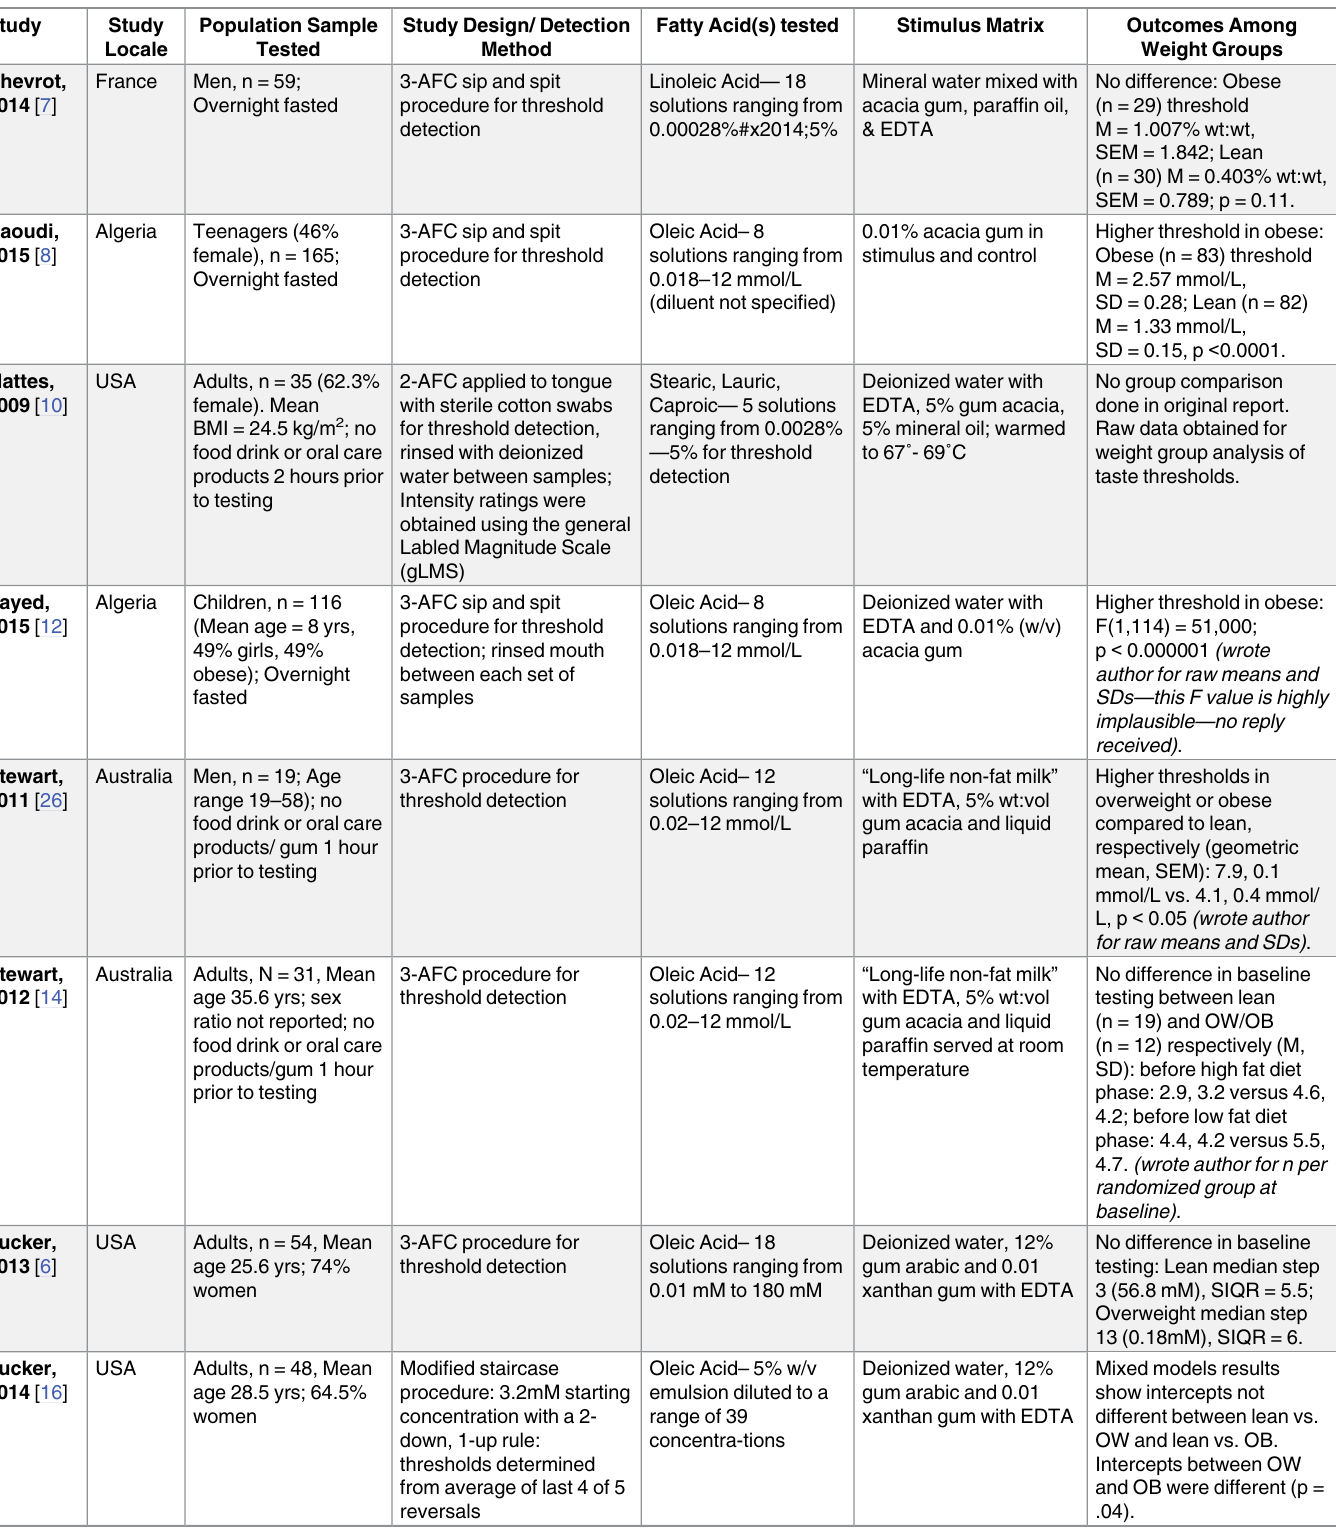
Table 1. Studies included in the